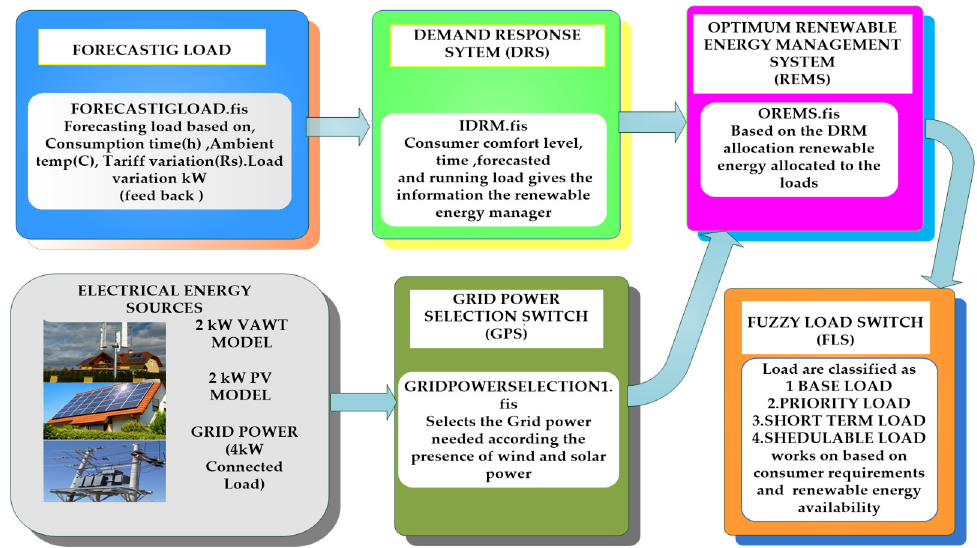
Figure 5. The architecture of the proposed smart (AuFuCo) controller.